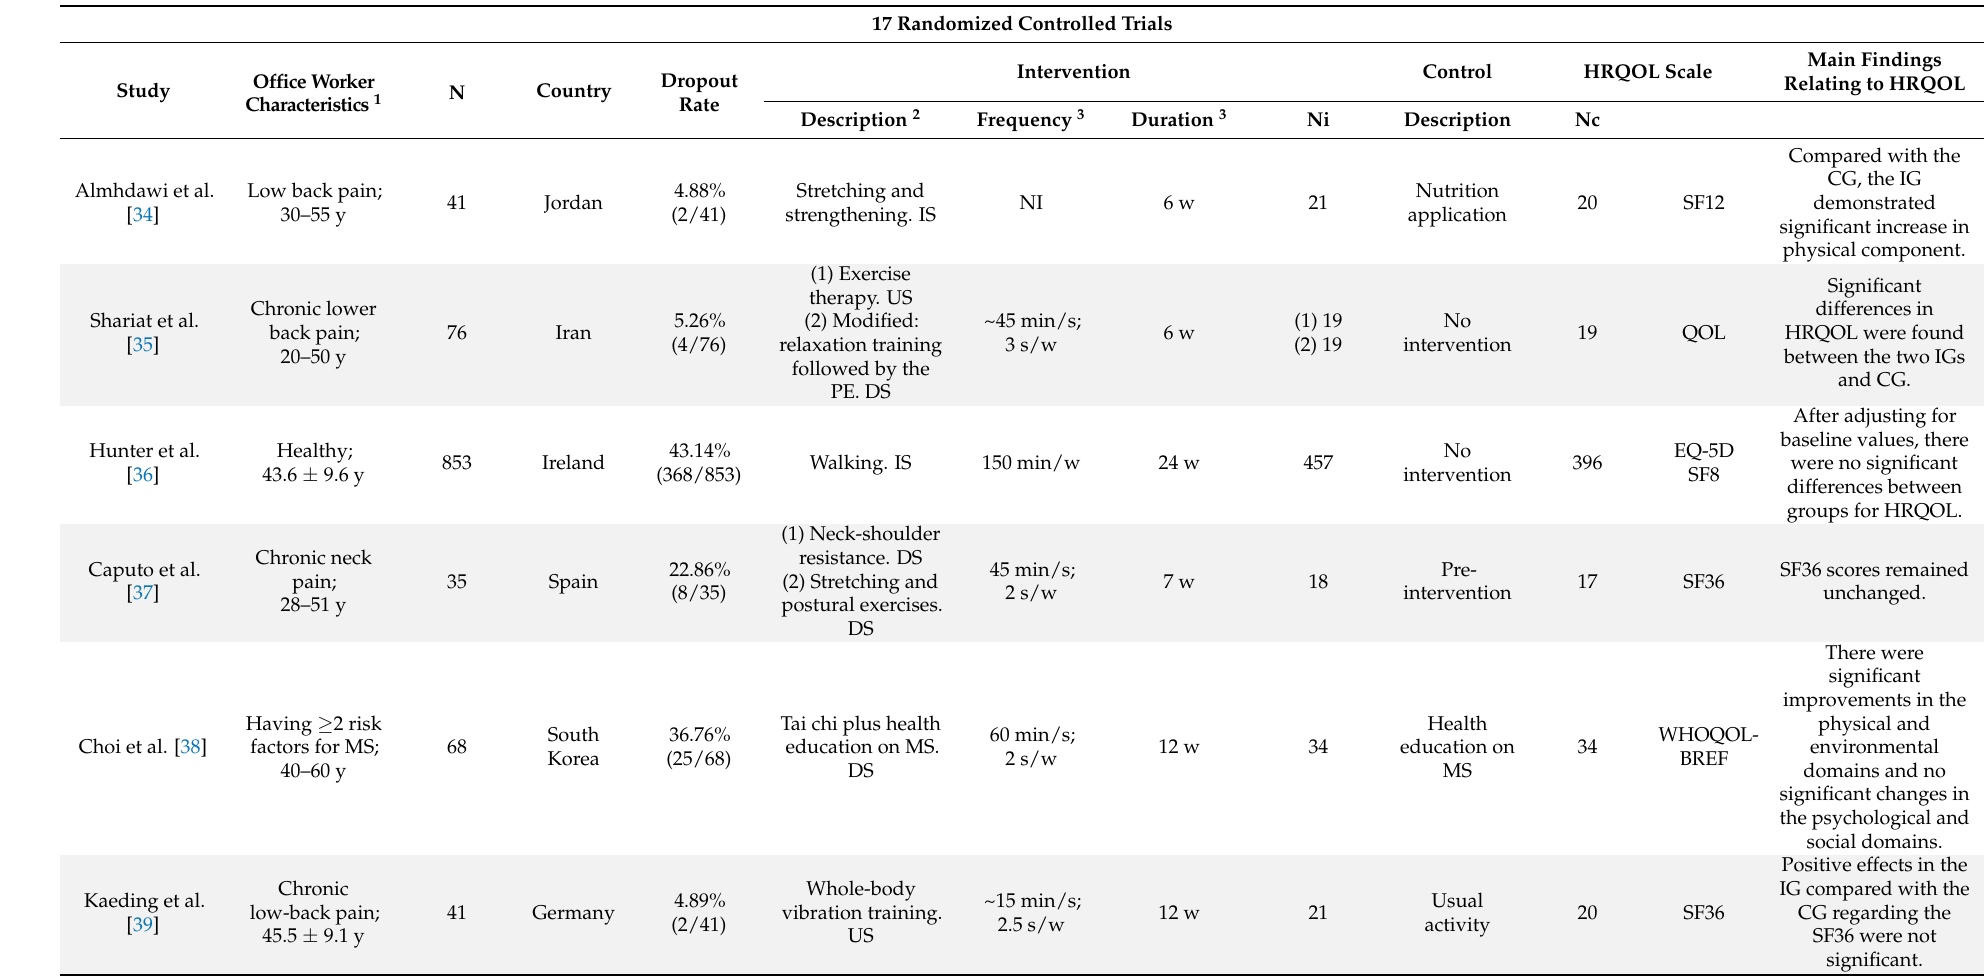
Table 1. Characteristics of the 26 included